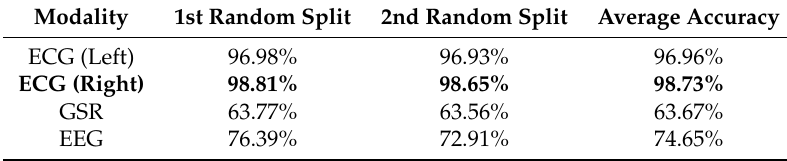
Table 3. Summary of results for AMIGOS dataset. Highlighted row represents best-performing